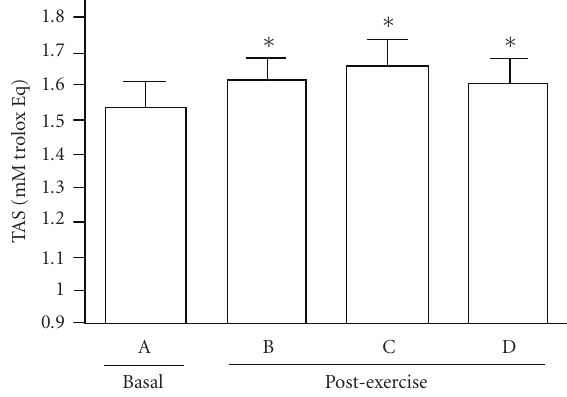
Figure 1: Total antioxidant status (TAS) in plasma from 34 male healthy subjects during basal (A) and immediately after a contin- uous progressive exercise test (B), a strenuous test performed until exhaustion (C) and a submaximal exercise (70% of the expected maximum workload) for 30 minutes (D). Data is expressed as mean ± standard error. ∗ denotes statistical di ff erences ( P < . 05) versus basal status.